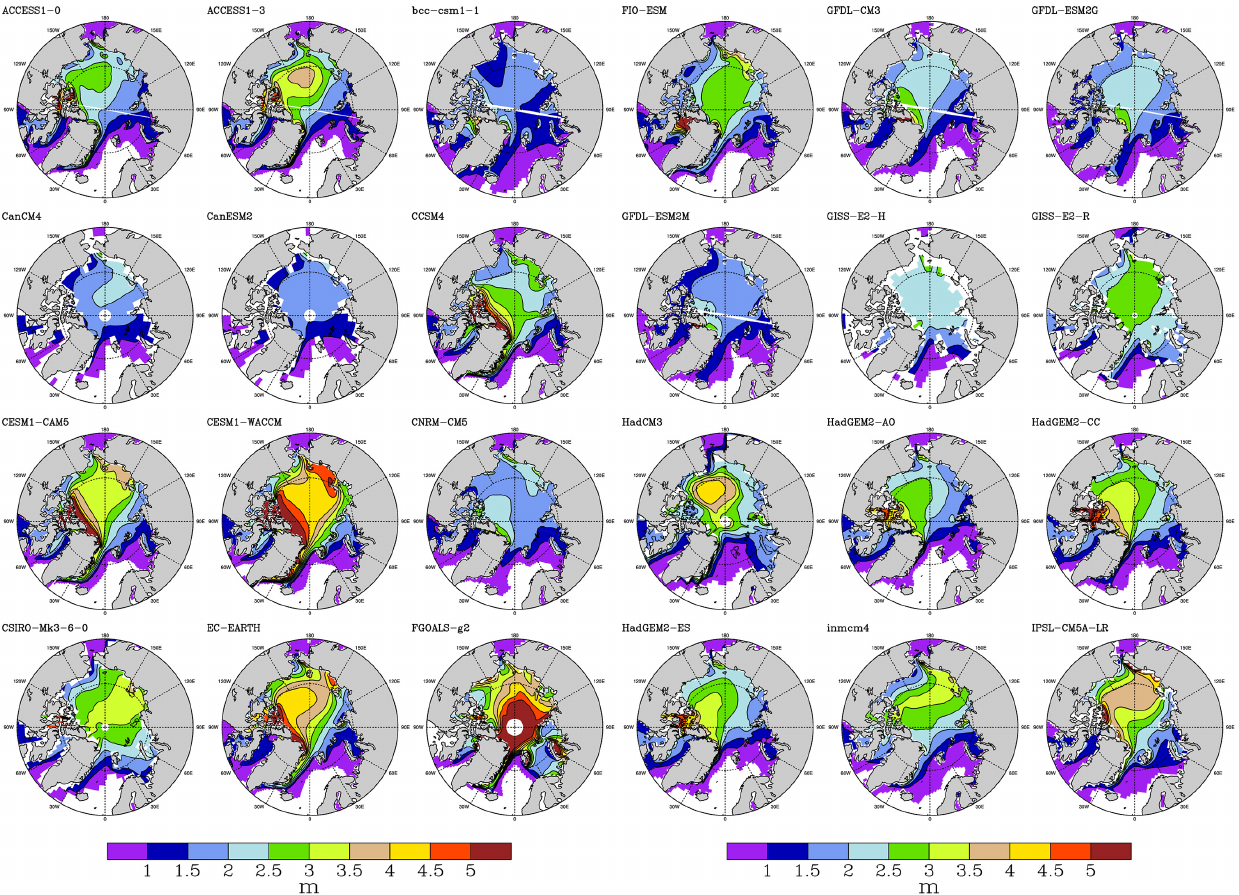
Figure 4. Spatial patterns of sea ice thickness from 1981 to 2010 from 33 CMIP5 models and PIOMAS.